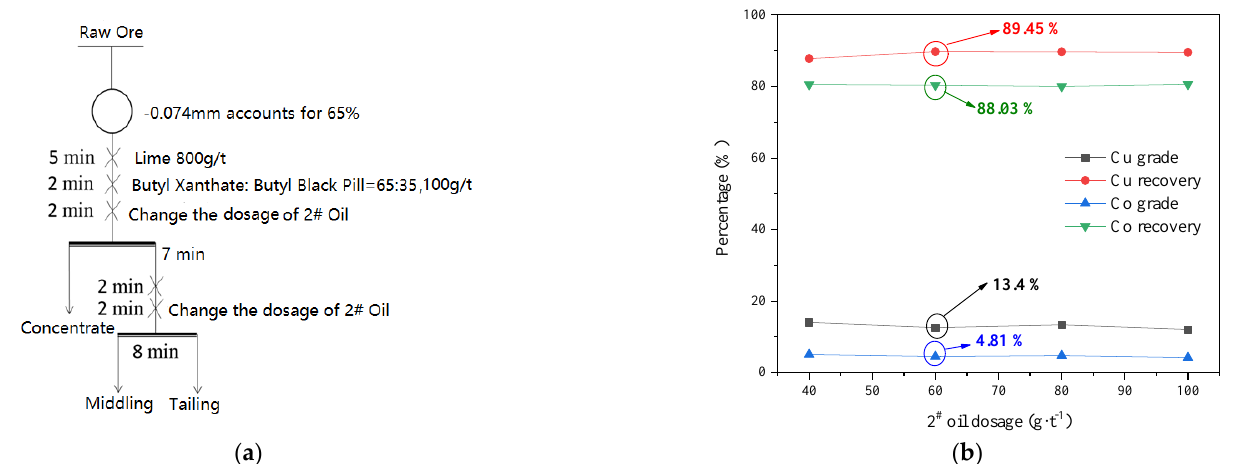
Figure 9. Effect of pH on the recovery of sulfide aggregates. ( a ) The flow chart for flotation experiments ( b ) Effect of Ph on the flotation recovery.